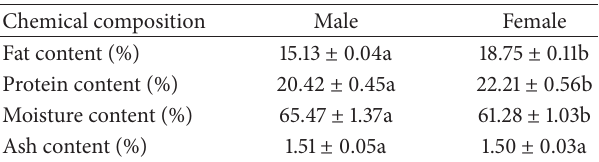
Table 1: Proximate composition (%) of males and females of Leuciscus lepidus .